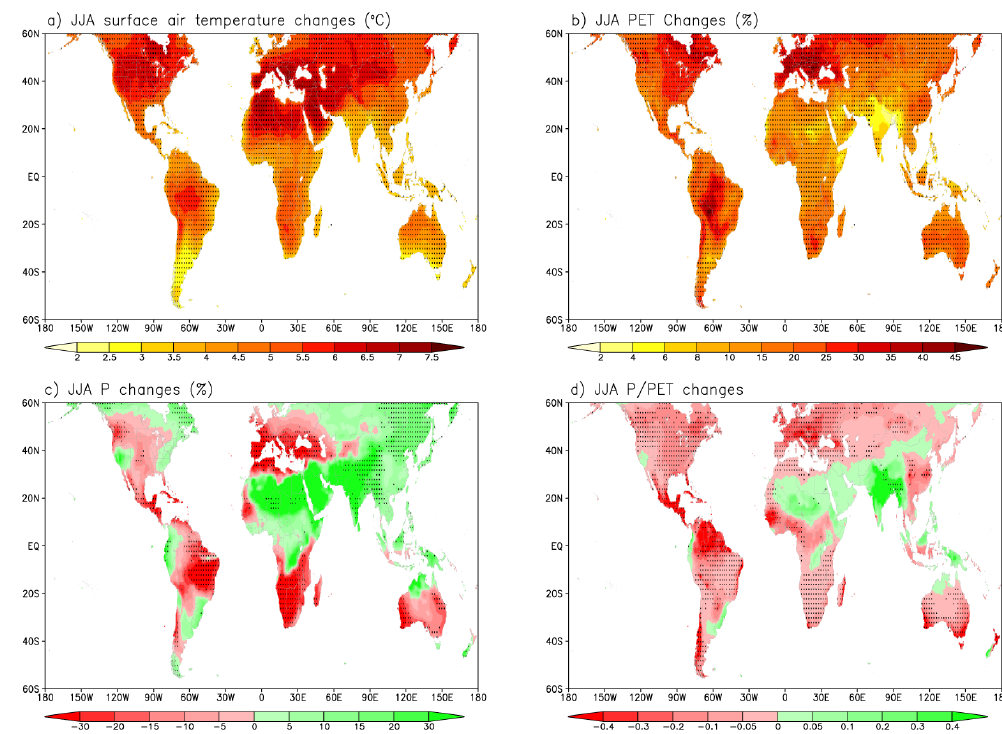
Fig. 13. Same as Fig. 7 but for the season of June–July–August.